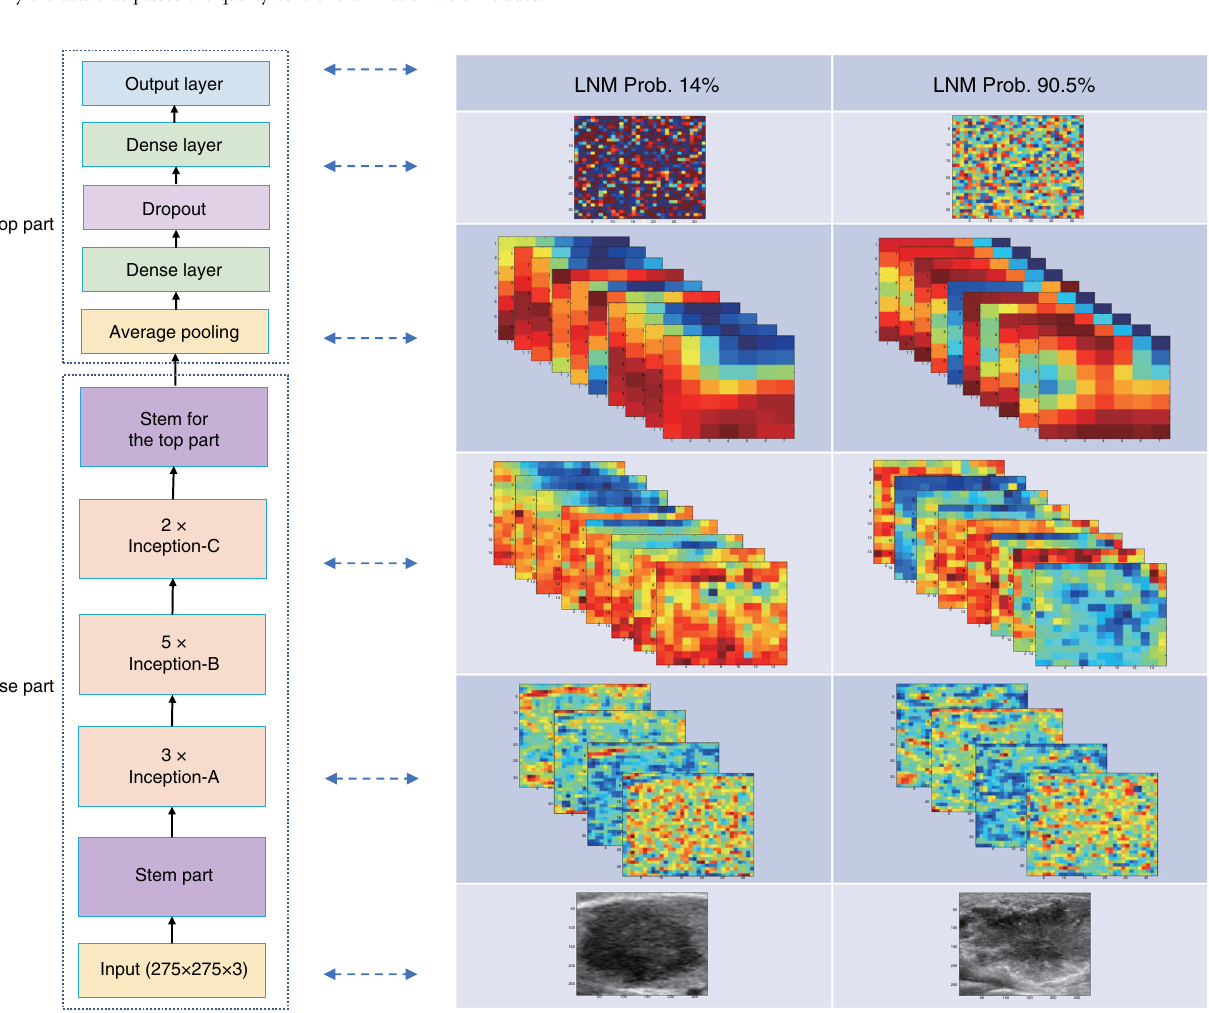
Fig. 6 Structure of transfer learning model and illustrations of middle layer output of an LNM positive case and a negative case. The left side shows the structure of our model, and the right side shows the middel layer output of two cases.